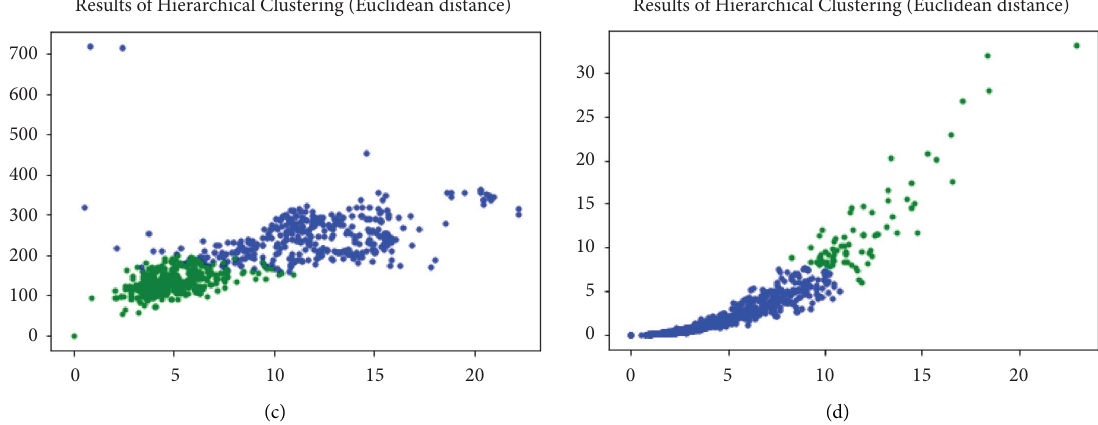
Figure 8: Clustering results of the hierarchical clustering method. (a) Feature vector f feature vector f h .